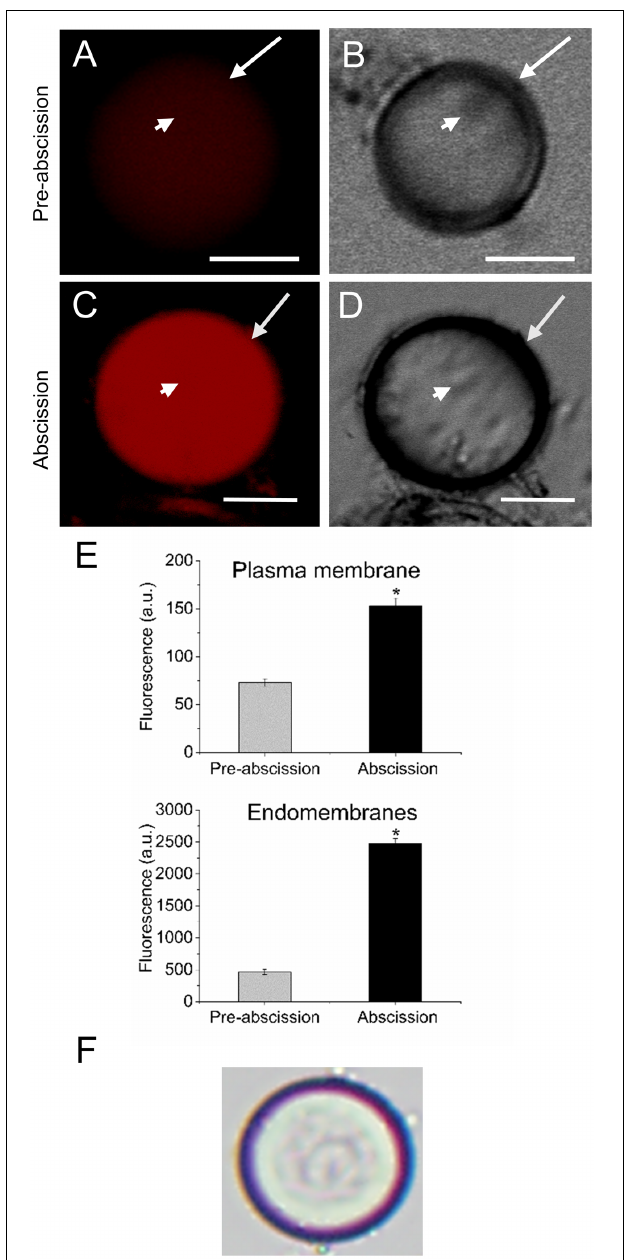
FIGURE 2 | Changes on polar lipid of live protoplasts from olive AZ during mature-fruit abscission. (A) Nile red stained protoplasts from the olive AZ at the pre-abscission stage compared to the white-light image (B) . (C) Nile red stained protoplasts from the olive AZ at the abscission stage compared to the white-light image (D) . (E) Effect of the abscission on polar lipid content in the plasma membrane and the intracellular membranes of fruit AZ protoplasts. About 10 protoplasts were acquired for each sample, and data were compiled with FV10 4.2 software (Olympus). Columns and bars indicate means ± SD, respectively, from five independent experiments. Statistically significant differences based on unpaired Student’s t -test at P < 0.05 are denoted by an asterisk. (F) Shows a protoplast after trypan blue treatment; trypan blue is excluded from the cytosol of intact cells (here shown after Nile red treatment). Scale bars are 5 µ m. Arrow: plasma membrane. Arrowhead: endomembranes.